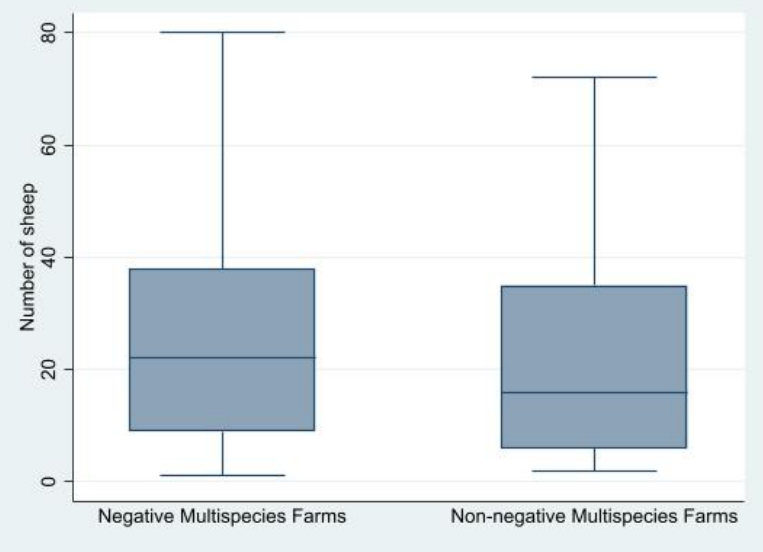
Figure 1. Distribution of the number of sheep within non-negative and negative multispecies farms. For the purposes of this study, all sheep belonging to the selected multispecies farms were tested for anti-SRLV antibodies, using the same commercial kit used for the first Tested Farms screening analysis (Id.Vet). Overall, 41 of the 51 non-negative multispecies farms and 52 of the 57 negative multispecies farms were tested. Seven (17%) SRLV-non-negative farms and fifteen (29%) CAEV-negative farms had at least one positive sheep. All data are re- ported in Table 3. Table 3. Descriptive statistics of SRLV results for sheep belonging to multispecies farms.